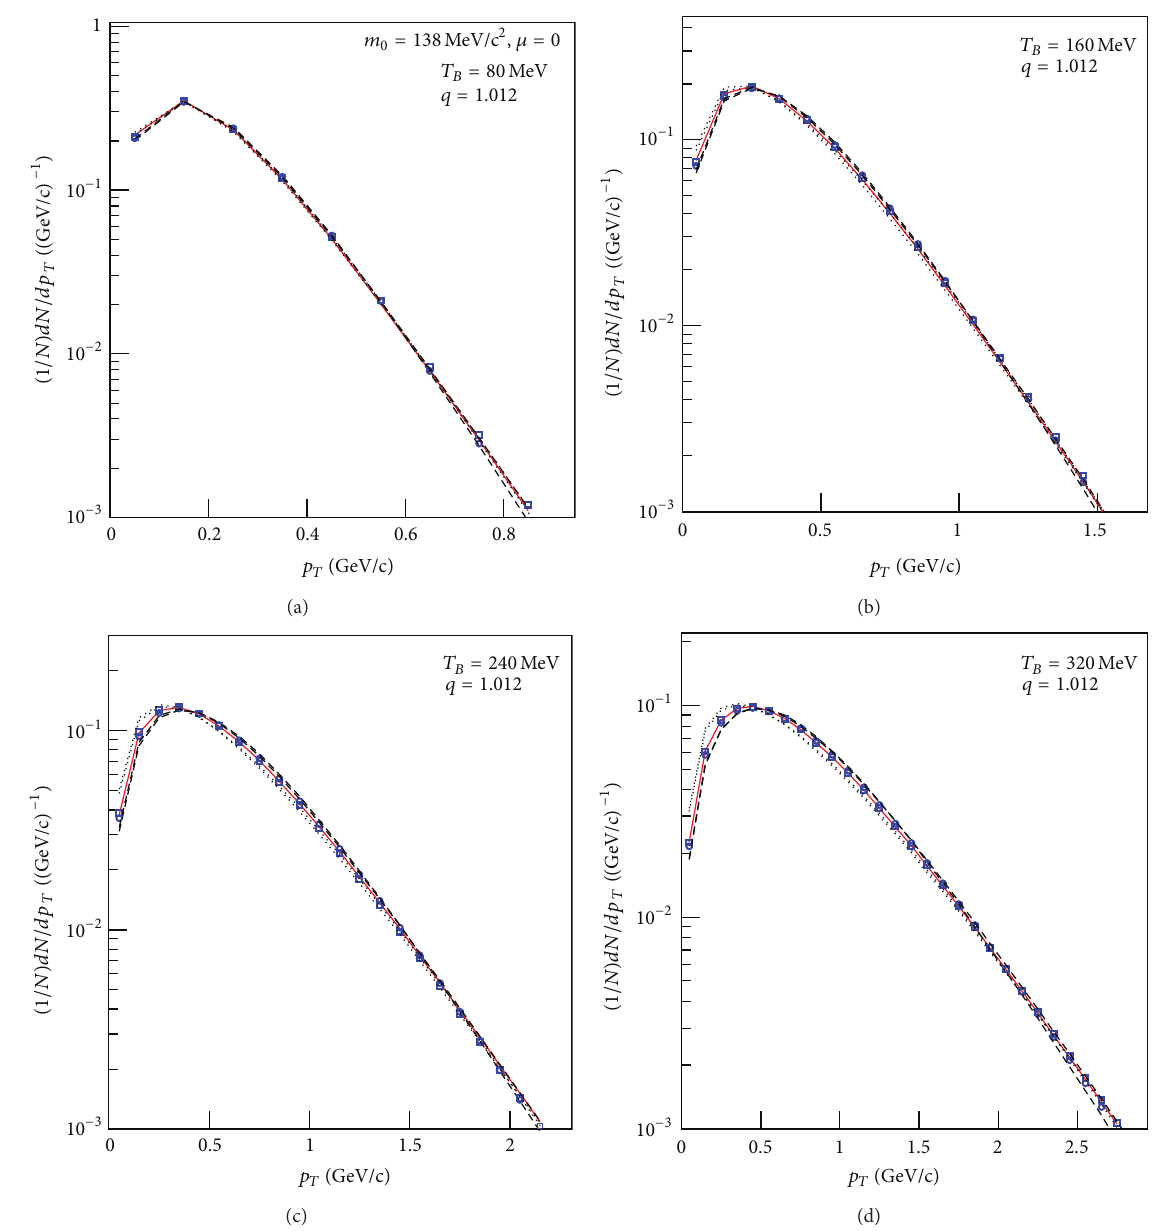
Figure 3: Comparisons of transverse momentum spectra for different distributions. Figures 3(a)–3(d) correspond to different 𝑇 𝐵 indicated in the panels and a given 𝑞 of 1.012. The meanings of the curves and symbols are the same as those for Figure